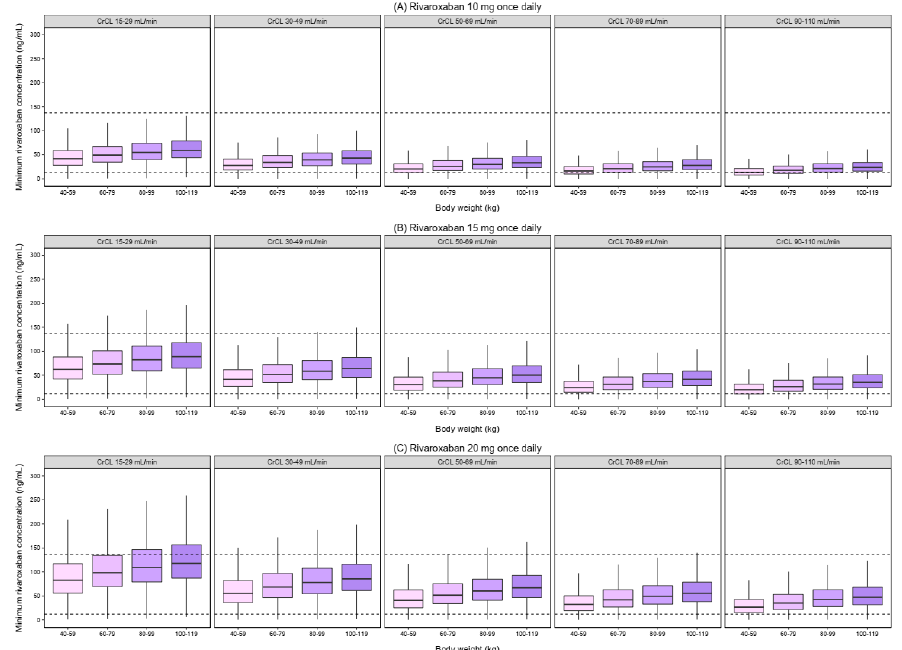
Figure 4. Simulated minimum concentration (C MIN ) of rivaroxaban with different dosing regimens. The boxplots represent the predicted C MIN stratified by creatinine clearance and body weight. ( A ) rivaroxaban 10 mg once daily. ( B ) rivaroxaban 15 mg once daily. ( C ) rivaroxaban 20 mg once daily. The dashed lines represent the 5th and 95th percentile ranges of the typical C MIN (12–137 ng/mL) reported in patients with non-valvular atrial fibrillation receiving 20 mg of rivaroxaban [19].